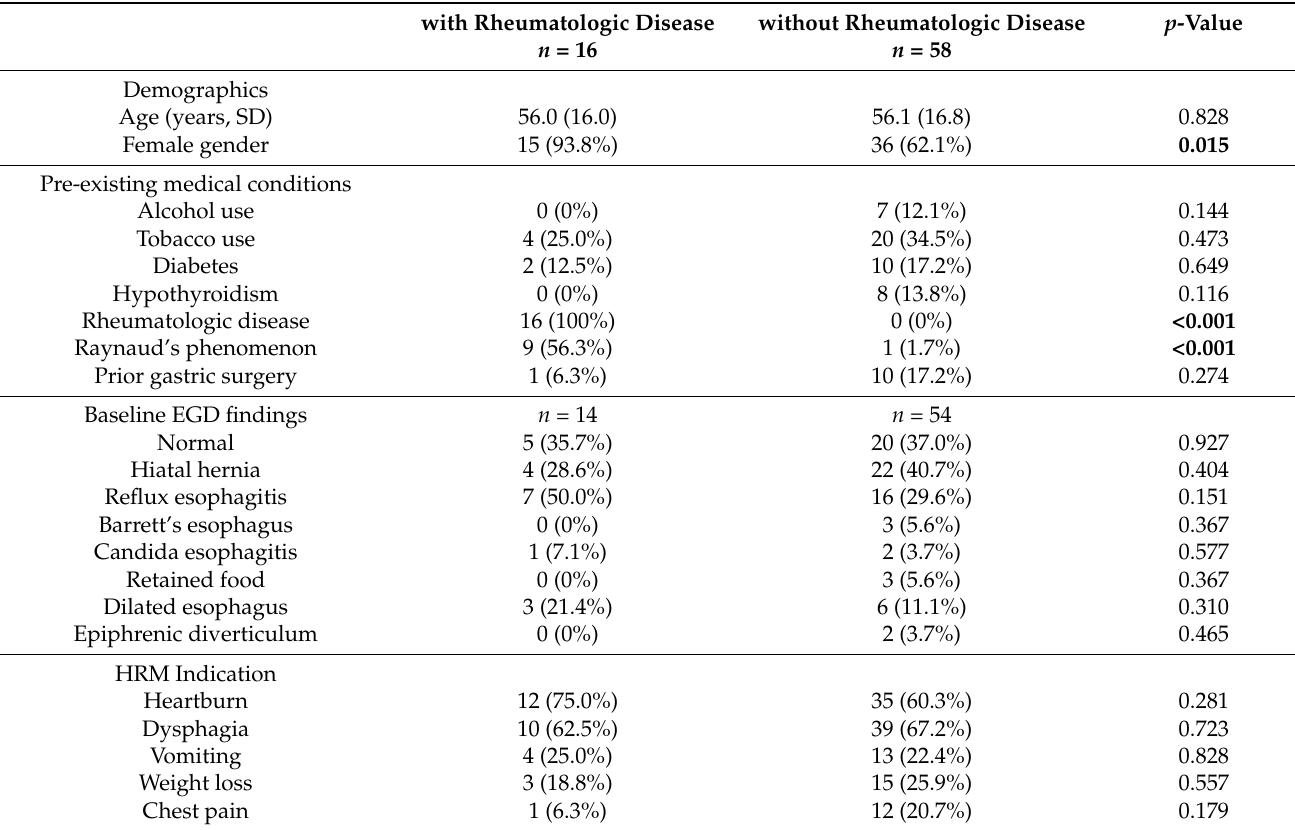
Table 3. Baseline characteristics of absent contractility patients with rheumatologic disease versus those without. with Rheumatologic Disease without Rheumatologic Disease